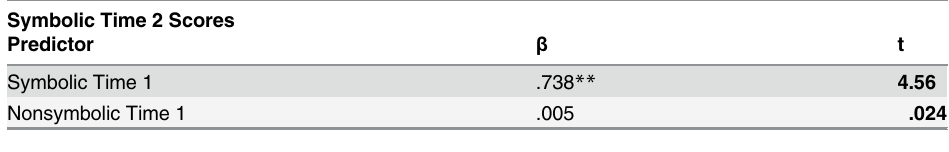
Table 1. Linear regression analysis predicting symbolic scores at Time 2 with symbolic and nonsym- bolic scores at Time 1 as predictors. Symbolic Time 2 Scores